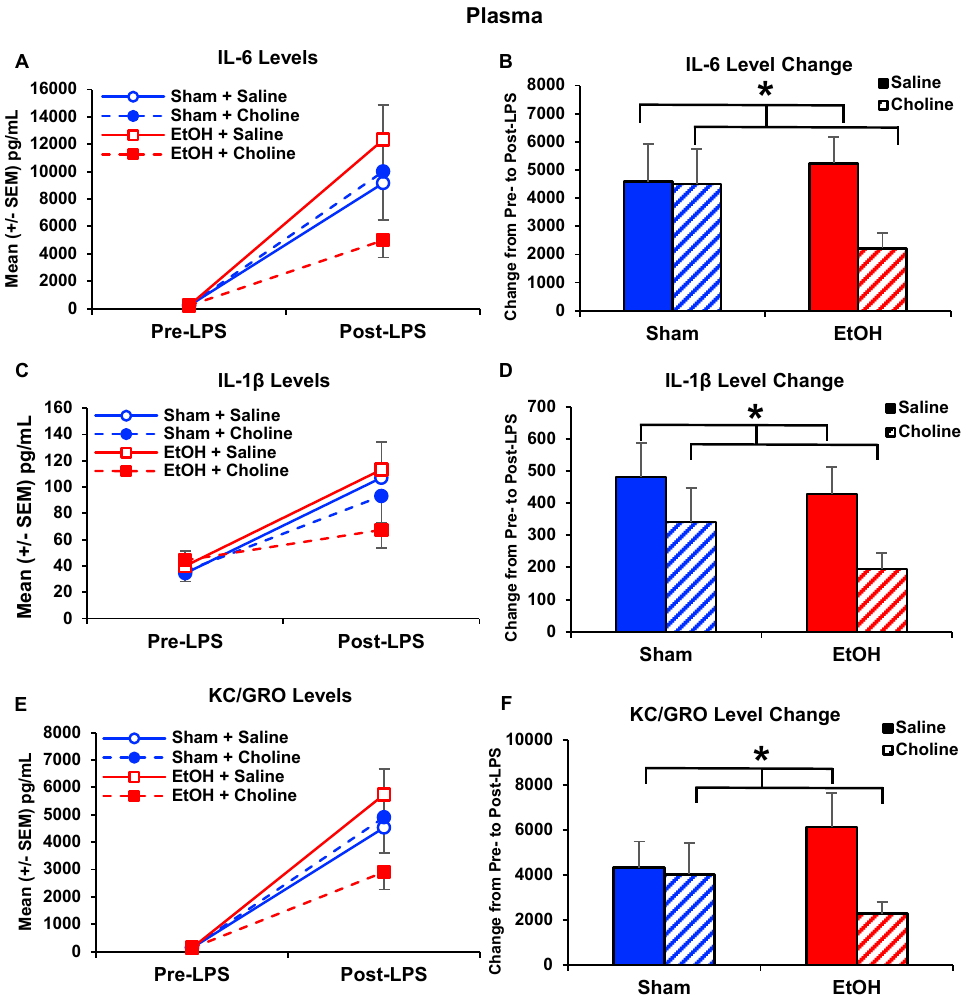
Figure 6. Early postnatal choline treatment reduces plasma cytokine release following immune challenge of LPS. There was a significant effect of choline supplementation, which reduced LPS-induced response in ( A , B ) IL-6 (Choline < Saline, * p < 0.05), ( C , D ) IL-1 β (Choline < Saline, * p < 0.05), and ( E , F ) KC/GRO (Choline < Saline, * p < 0.05), an effect that was largely driven by ethanol-exposed subjects. n = 21–22 per group.